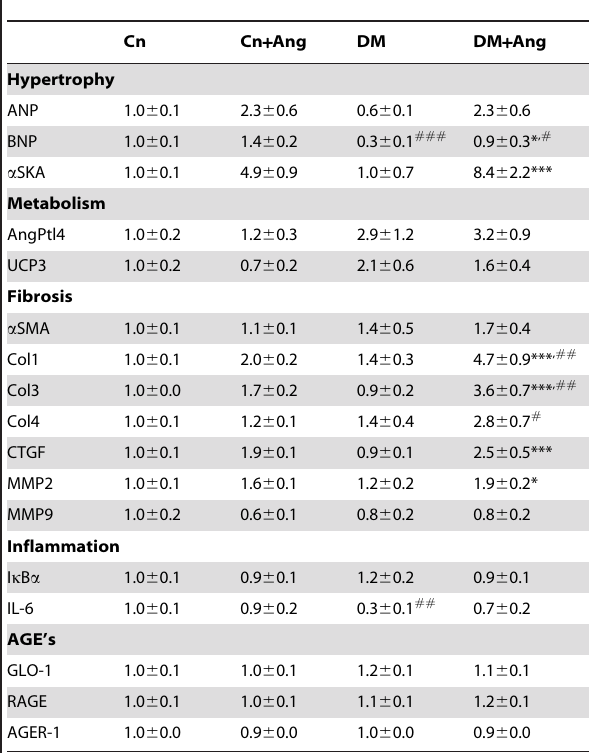
Data are expressed relative to non-diabetic vehicle-treated mice as mean 6 SEM. Abbreviations are explained in Table S1. * refers to effect of AngII in non- diabetic and diabetic mice (* P , 0.05, ** P , 0.01, *** P , 0.001) and # refers to effect of diabetes in vehicle-treated and AngII-treated mice ( # P , 0.05,